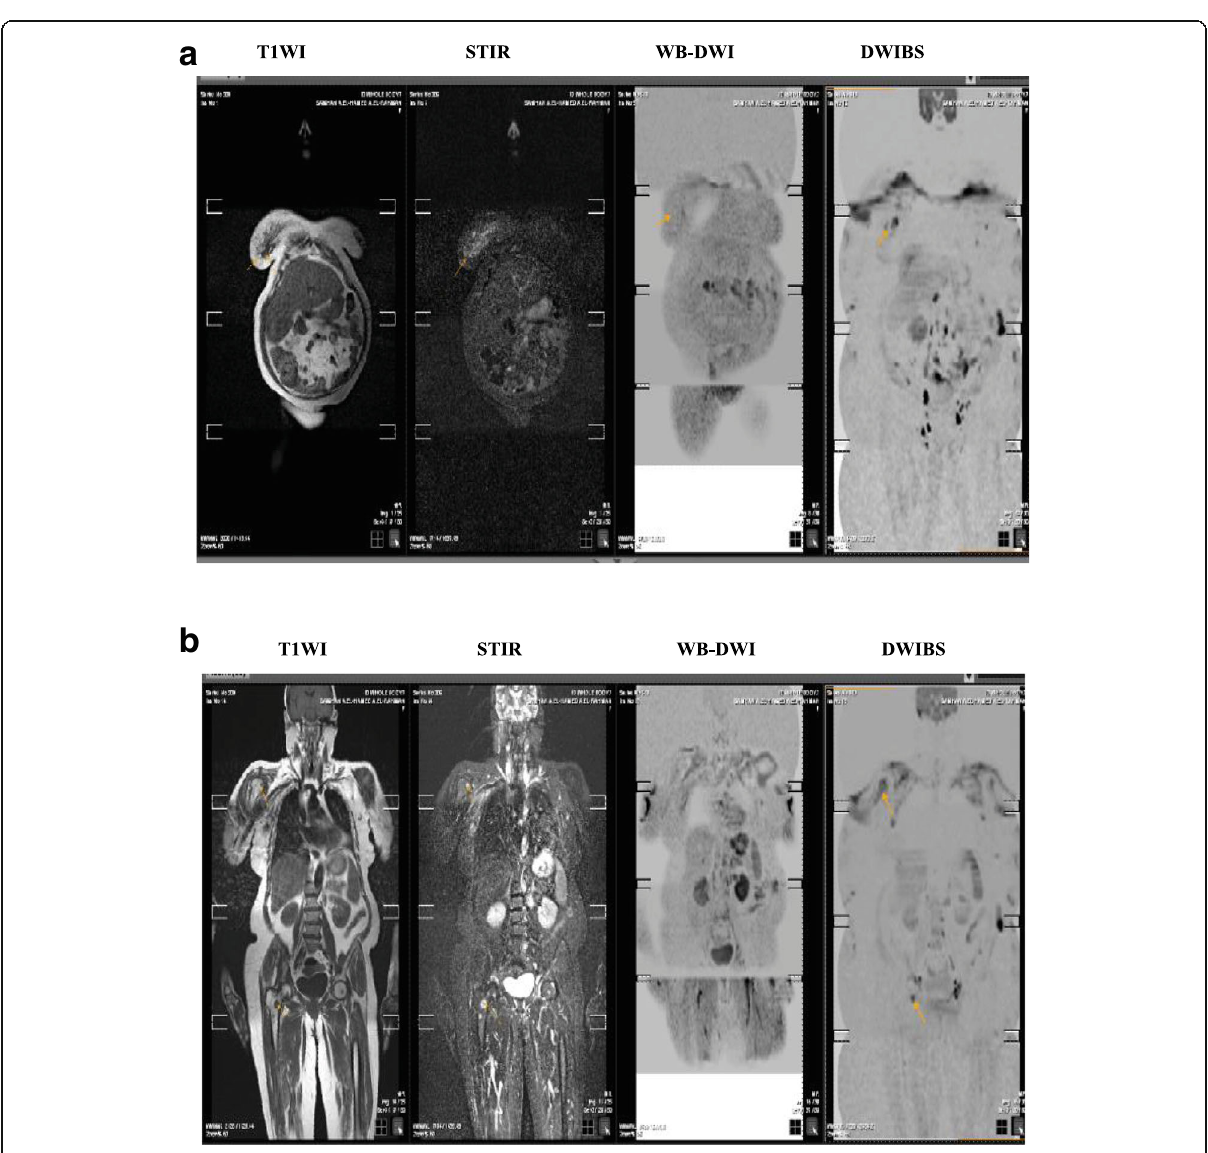
Fig. 2 A 46-year-old female diagnosed as invasive duct carcinoma GII right breast. a Rt. breast lesion appears hypointense in A T1WI, hyperintense in B STIR, and restricted in D DWIBS but it does not appear on C WB-DWI due to inadequate fat suppression. b Rt. humerus and right femur lesion are seen hypointense in A coronal T1WI, hyperintense in coronal STIR (B), and restricted in DWIBS (D), but not seen at WB-DWI (C) due to inadequate fat suppression. DWIBS can detect both the breast lesion and osseous metastasis and the time of examination was about 10 min. (Correlated with bone scan and